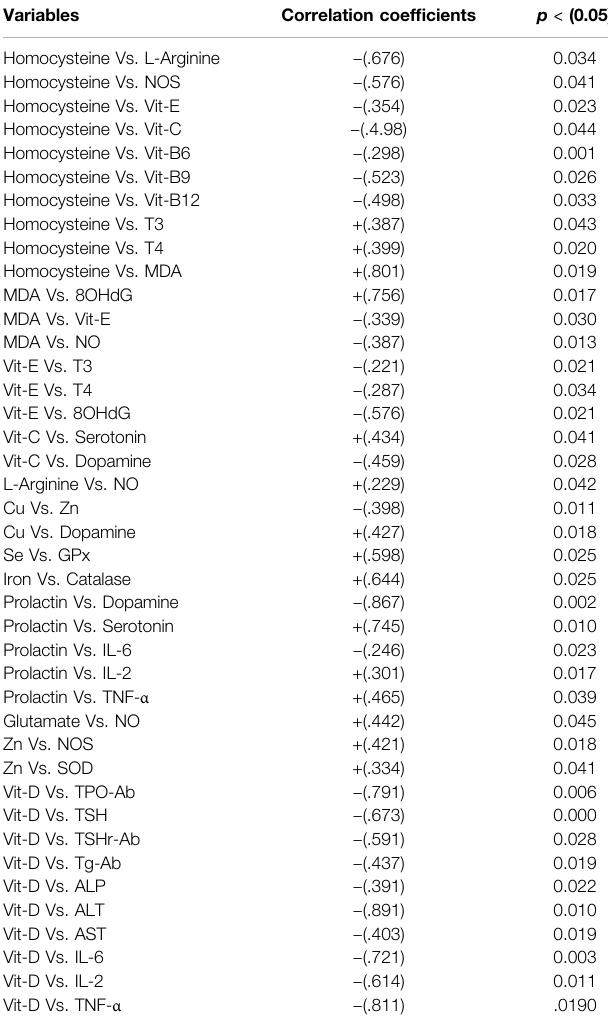
TABLE 9 | Pearsons ’ correlation coef fi cients of prominent variables in the development of thyroid dysfunction in schizophrenics.